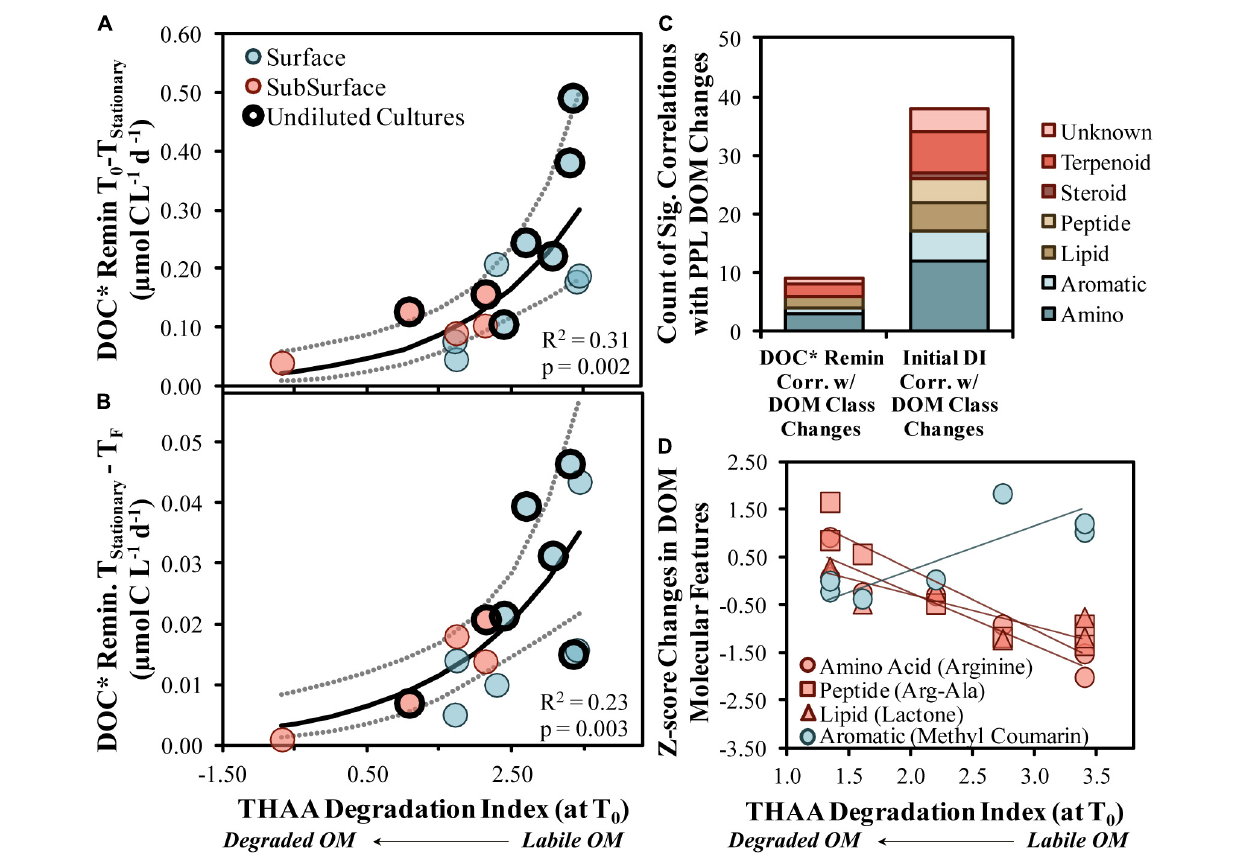
FIGURE 7 | Short- (A) and long-term (B) DOC* drawdown in OM remineralization experiments compared with the initial THAA-based degradation index (DI) score. Model II non-linear fits are represented by solid lines while dotted lines surrounding these fits represent the ± 95% confidence intervals. Counts of compound class changes in MS1 peak area between initial and stationary phases that have significant ( p < 0.05) correlations with either the short-term DOC* remineralization rate or the initial THAA-based DI (C) . Four example scatter plots between the initial THAA-based DI and z-score changes are shown in (D) . A z -score change of –1.0 refers to one standard deviation decrease for that compound. DOC* denotes that concentrations were corrected for bacterioplankton carbon but contain an unconstrained contribution of C < 3.0 µ